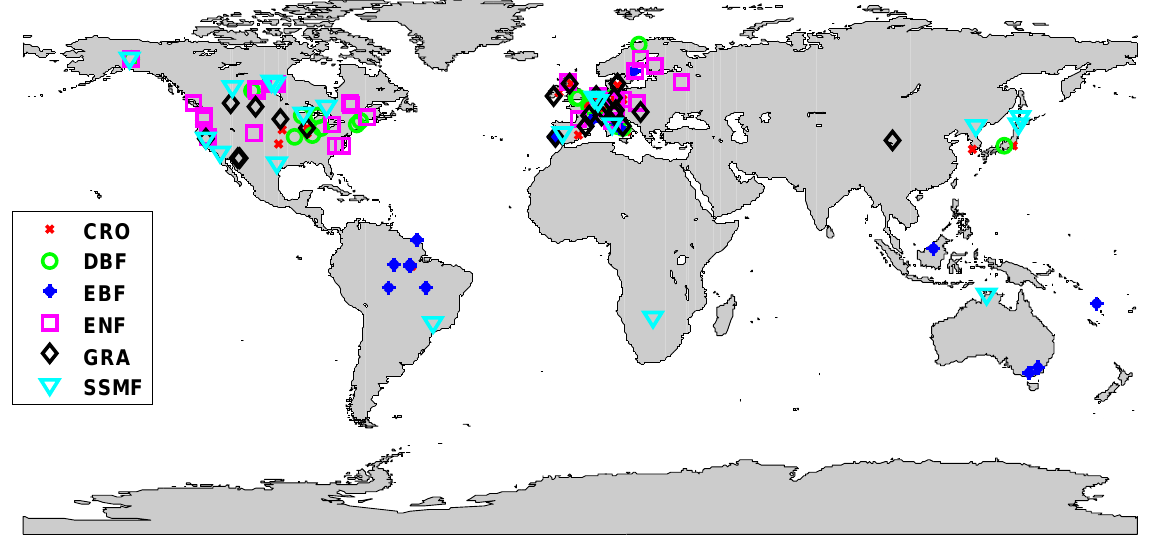
Fig. 1. Location of 144 sites used in this study from the La Thuile data set. Table 2. Total number of sites and site-years used in this study from the La Thuile data set. CRO, DBF, EBF, ENF and GRA are cropland, deciduous broadleaf forest, evergreen broadleaf forest, evergreen needleleaf forest and grassland, respectively. The category SSMF includes open and closed shrublands, savannas, woody savannas and mixed forest sites.